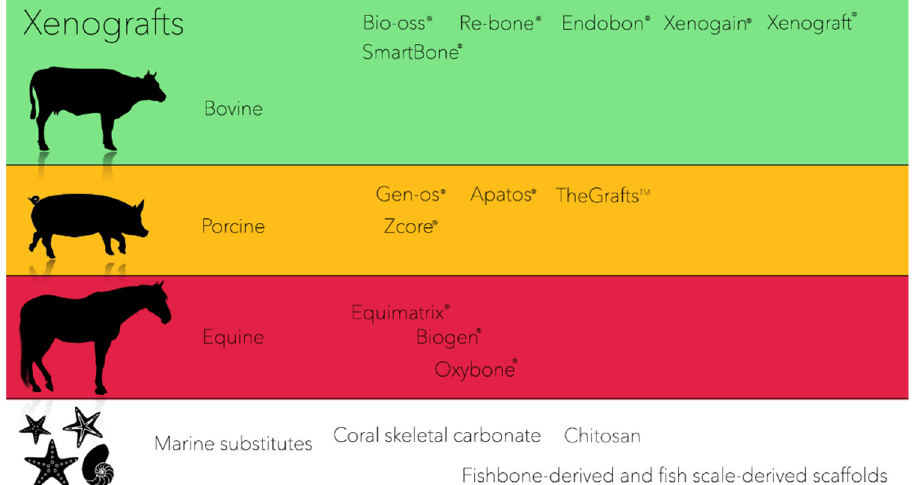
Figure 1. Examples of xenografts substitutes on the market.